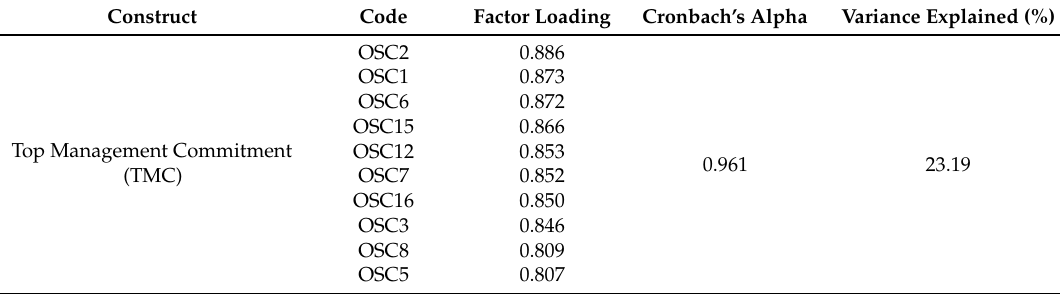
Table 1. Exploratory factor analysis of safety